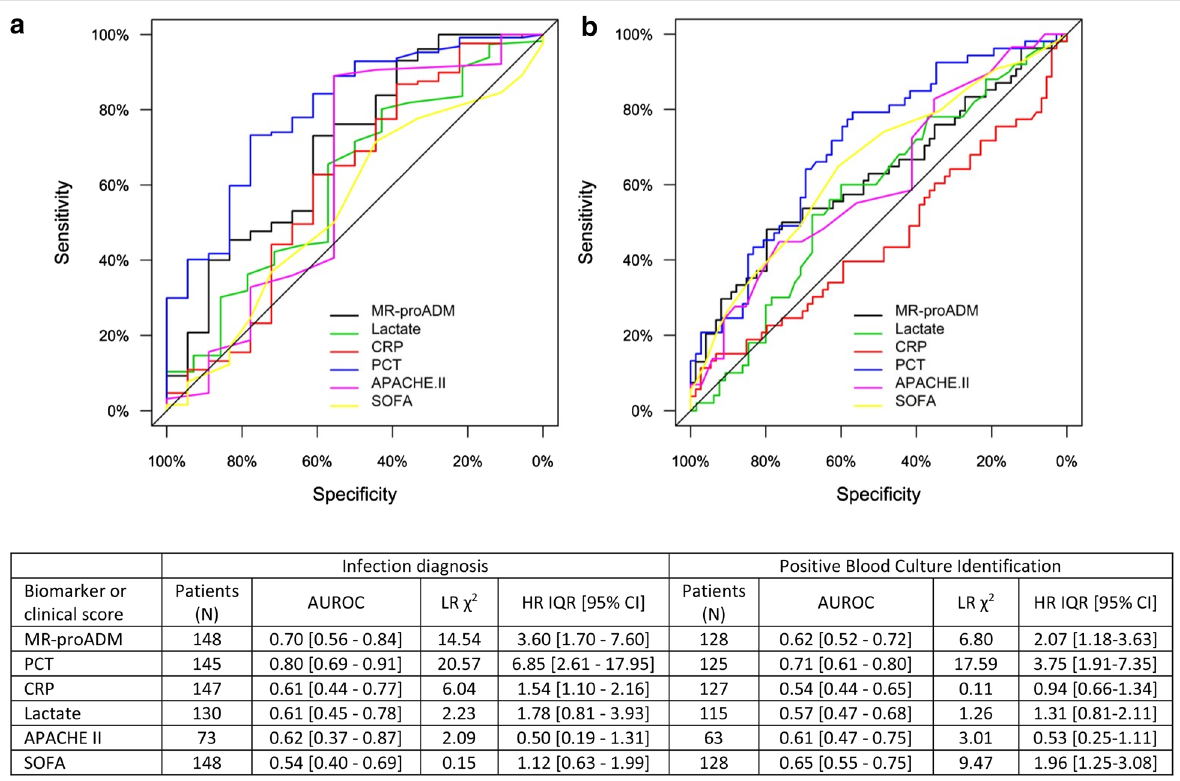
Fig. 1 AUROC and univariate analysis for a discriminating between patients with a final diagnosis of infection from those where no infection was found, after activation of an in‑hospital sepsis code, and b prediction of a positive blood culture in patients with a final diagnosis of infection. APACHE II Acute Physiological and Chronic Health Evaluation II score, AUROC area under the receiver operating characteristic curve, CI confidence interval, CRP C‑reactive protein, HR hazard ratio, IQR interquartile range, LR likelihood ratio, MR ‑ proADM : mid‑regional proadrenomedullin, N number, PCT procalcitonin, SOFA Sequential Organ Failure Assessment